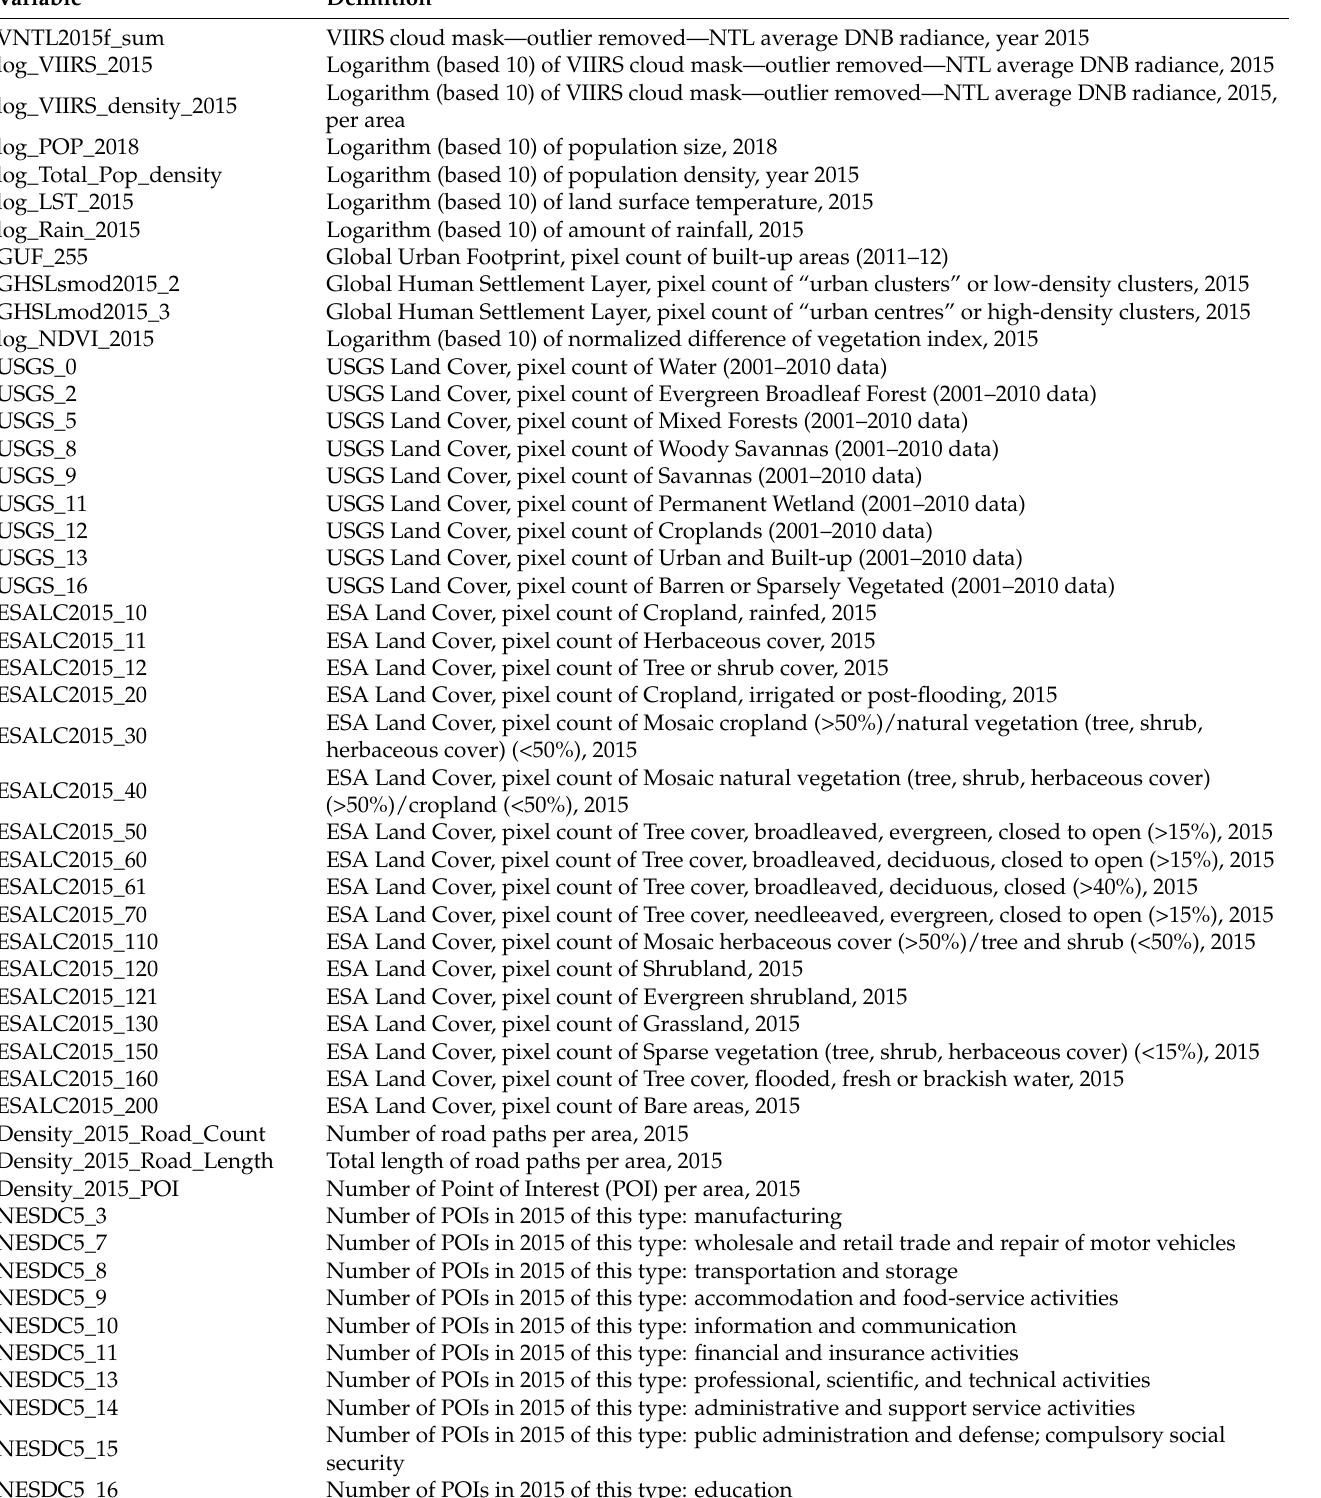
Table A1. List of variables obtained from geospatial data of